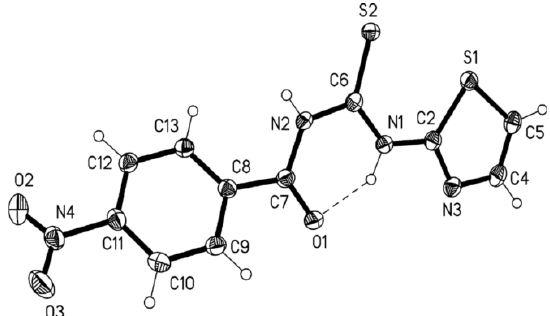
Figure 1. A thermal ellipsoid drawing of 1-(4-nitrobenzoyl)-3-(thiazol-2- yl)thiourea (1a) at 50% probability level. The dashed line shows intramolecular hydrogen